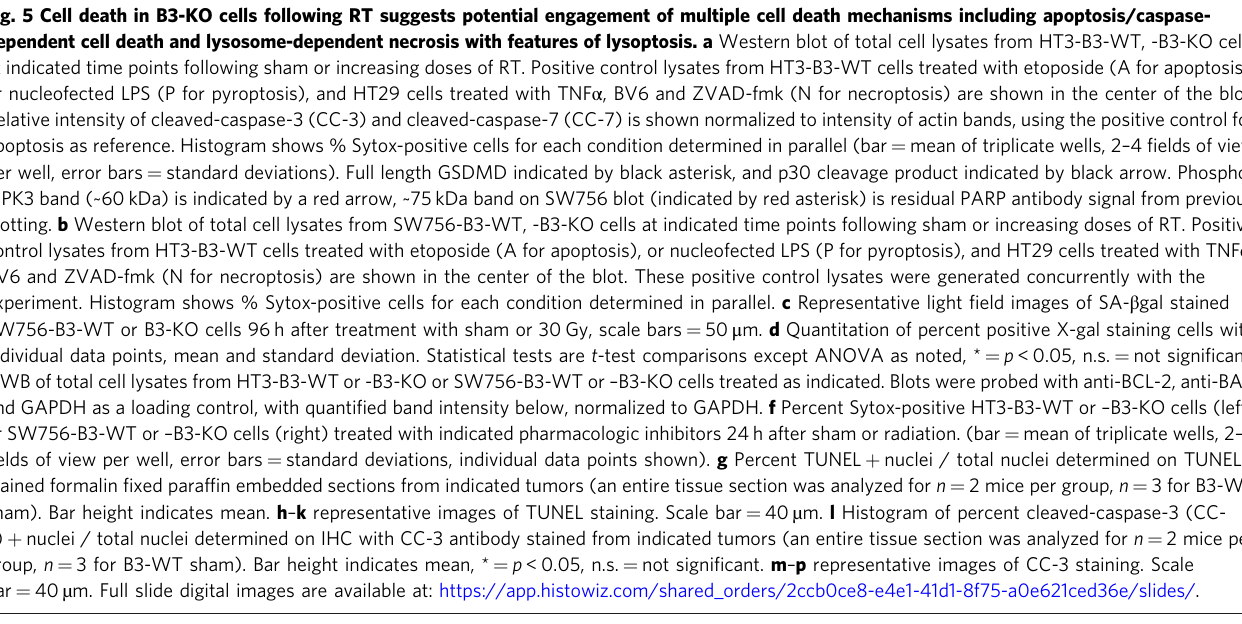
Fig. 5 Cell death in B3-KO cells following RT suggests potential engagement of multiple cell death mechanisms including apoptosis/caspase- dependent cell death and lysosome-dependent necrosis with features of lysoptosis. a Western blot of total cell lysates from HT3-B3-WT, -B3-KO cells at indicated time points following sham or increasing doses of RT. Positive control lysates from HT3-B3-WT cells treated with etoposide (A for apoptosis), or nucleofected LPS (P for pyroptosis), and HT29 cells treated with TNF α , BV6 and ZVAD-fmk (N for necroptosis) are shown in the center of the blot. Relative intensity of cleaved-caspase-3 (CC-3) and cleaved-caspase-7 (CC-7) is shown normalized to intensity of actin bands, using the positive control for apoptosis as reference. Histogram shows % Sytox-positive cells for each condition determined in parallel (bar = mean of triplicate wells, 2 – 4 fi elds of